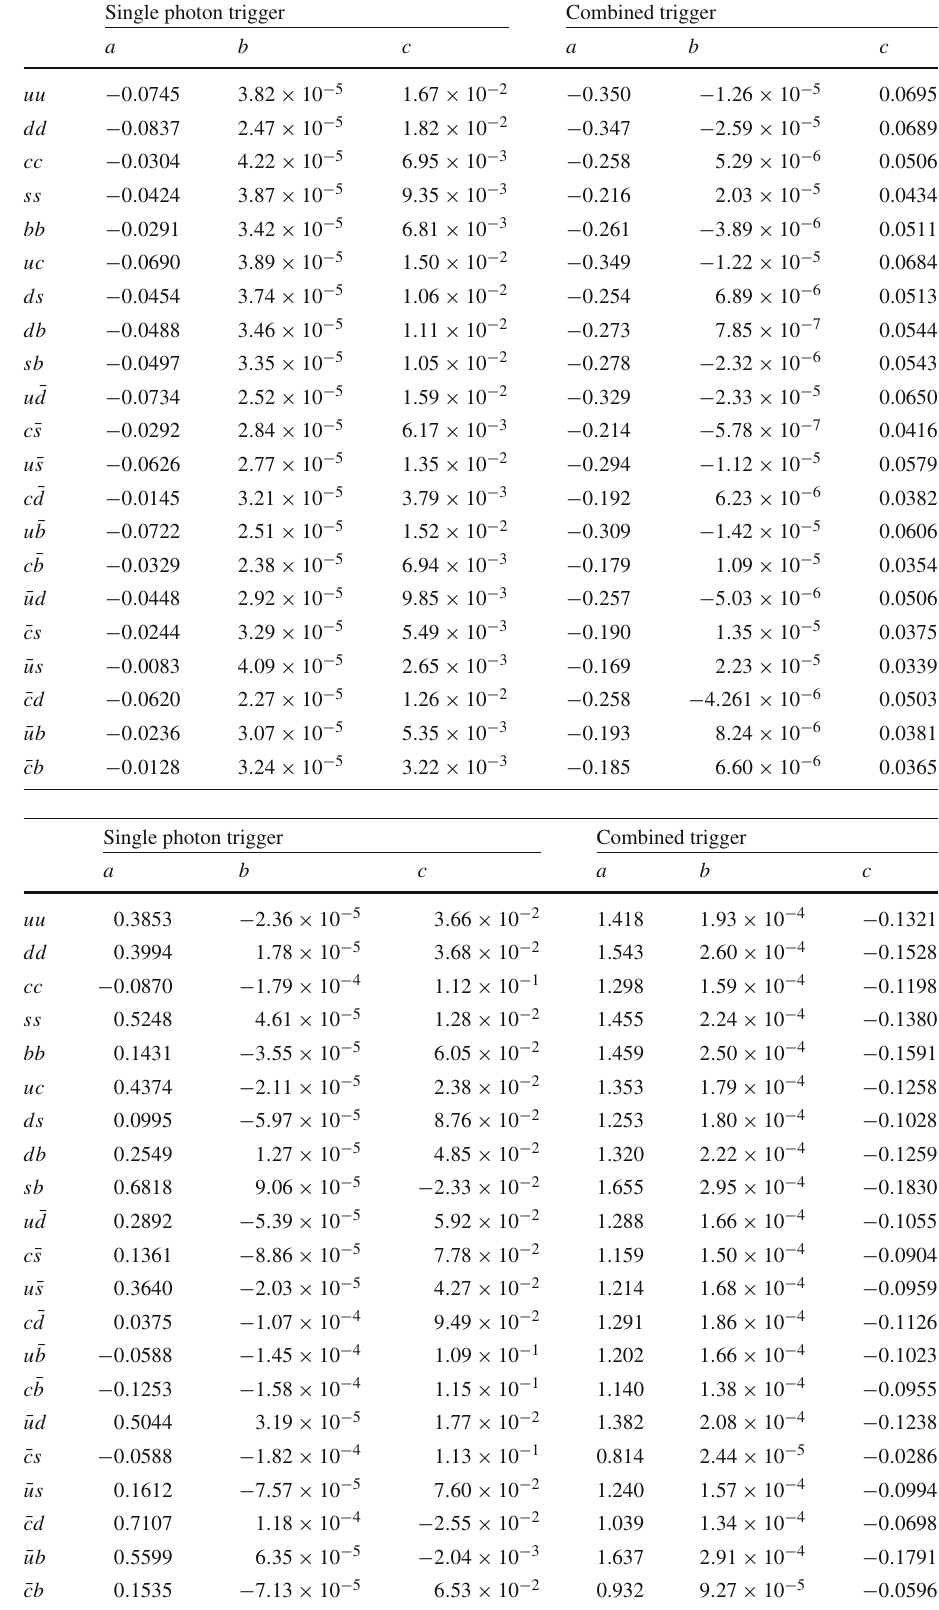
Table 8 Fit coefficients of A initial in the two trigger categories (left/right) for a neutral (top), positively charge (middle), and negatively charged (bottom) particle for the different initial state flavours